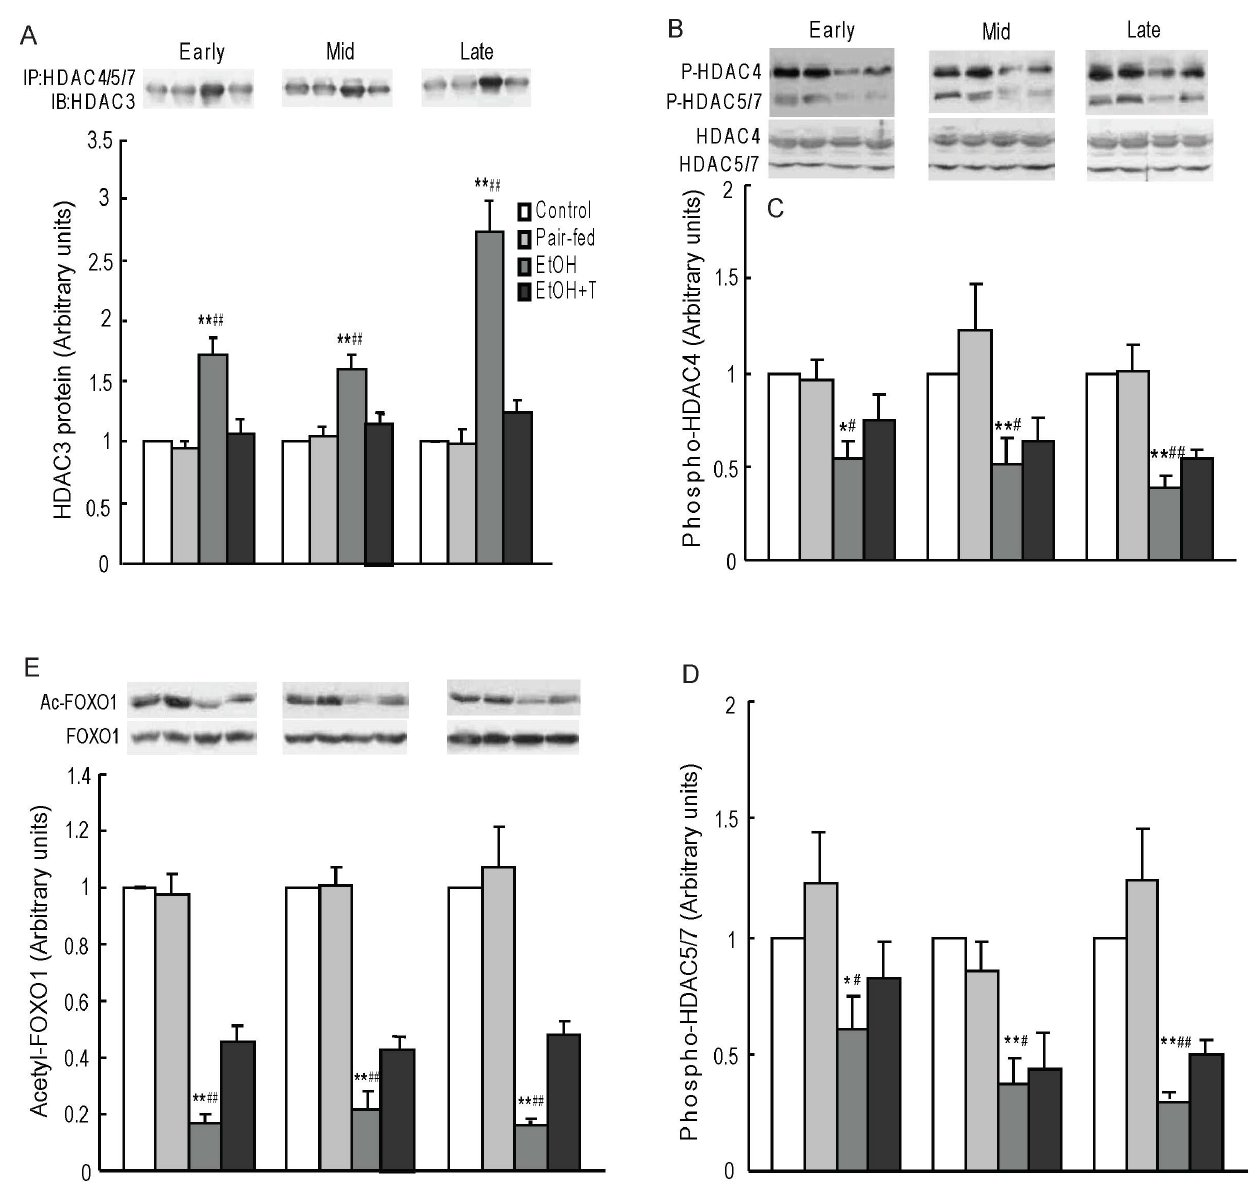
Figure 6. Hepatic nuclear HDAC3 protein content immunoprecipitated (IP) with HDAC4/5/7 antibody (A), representative western blot of cytosolic phospho-HDAC4,5, and 7 (B), cytosolic level of phospho-HDAC4 (C) and phospho-HDAC5/7 (D), and nuclear content of acetyl-foxo1 protein (E) in 4 month-old male rat offspring exposed to ethanol (EtOH) or water only during early, mid, or late pregnancy. Control and pair-fed offspring were from dams with free access to chow and dams fed the amount of chow consumed by EtOH dams, respectively. A subgroup of EtOH rats was given TUDCA (T) 3 weeks before the experiments. Data shown as the mean 6 SE, n=6. *P , 0.05, **P , 0.01 EtOH vs. control; # P , 0.05, ## P , 0.01 EtOH vs .